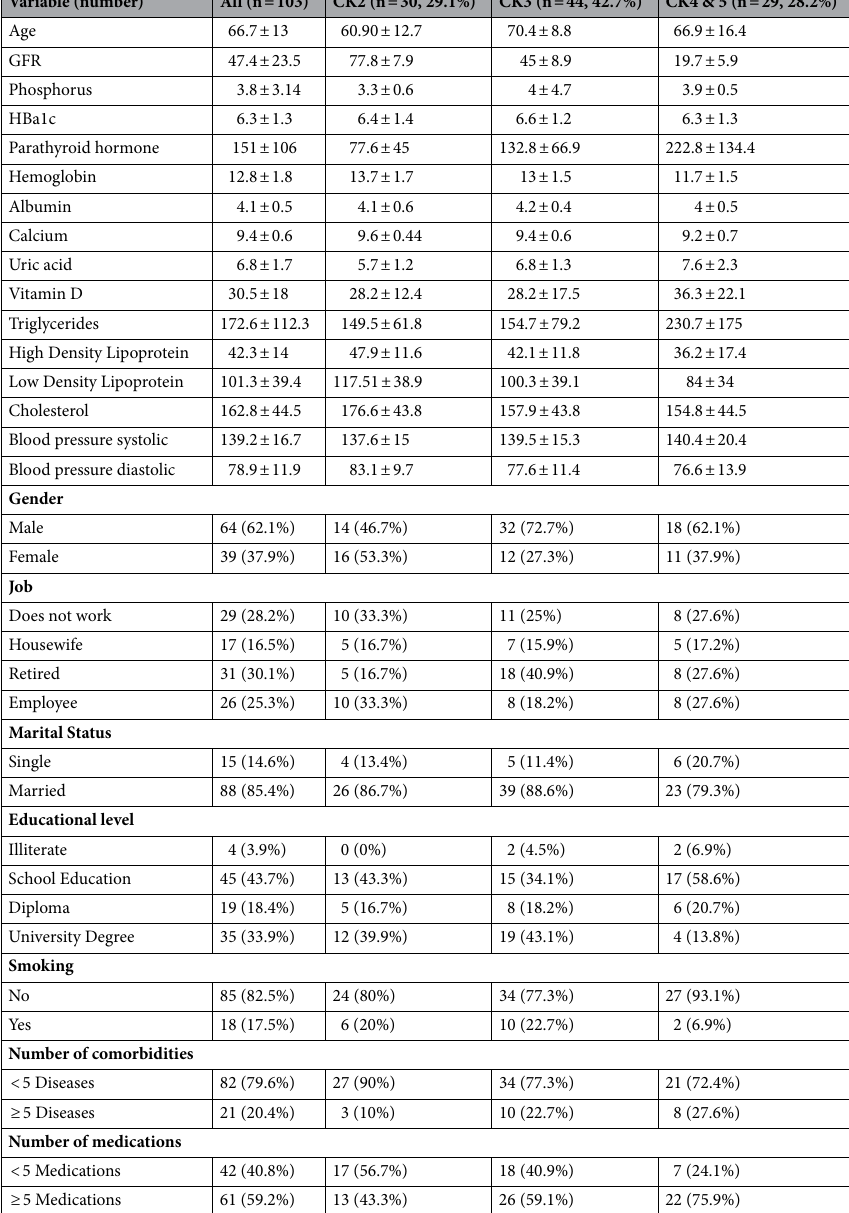
Table 1. Sociodemographic characteristics, clinical and laboratory parameters according to the stage of CKD.